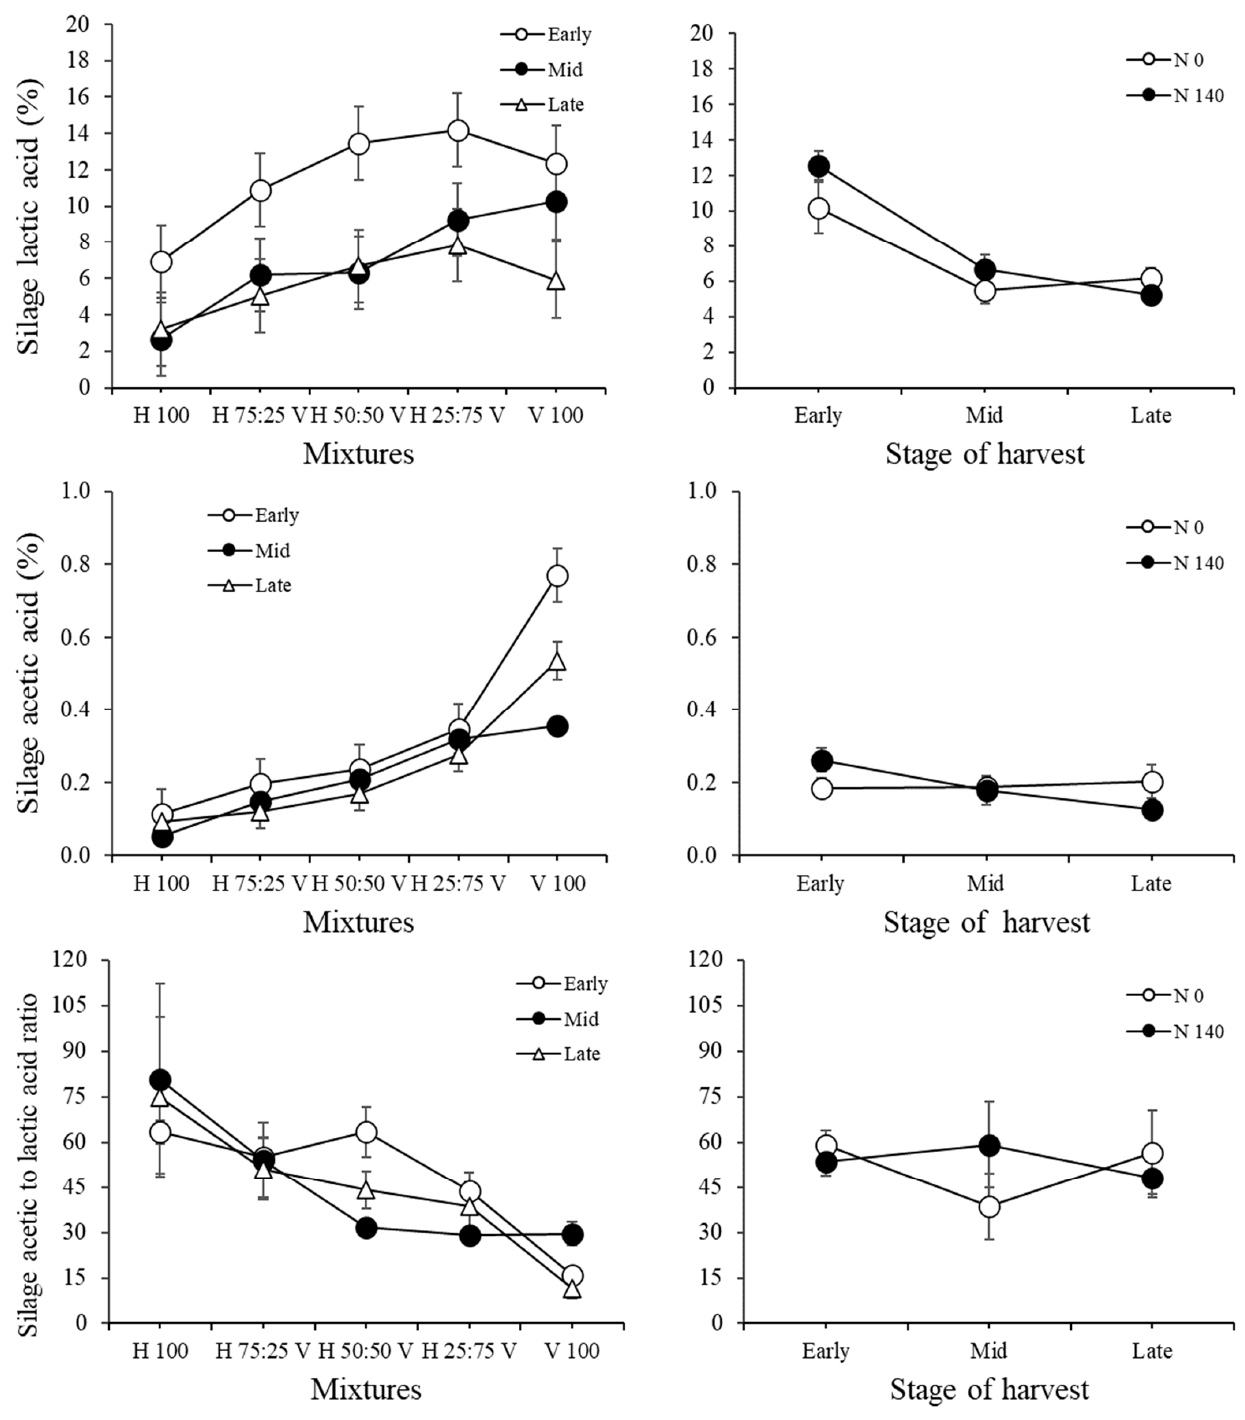
Figure 15. Silage lactic acid concentration ( above ), acetic acid concentration ( middle ) and acetic to lactic acid ratio ( below ) as affected by SH × MX interaction ( left ) and SH × NF interaction ( right ). On the left, values are LSmeans across all treatments along with standard error estimate of the LSmeans since the design was unbalanced between the faba bean crop ( n = 9) compared to the mixtures and the barley crops ( n = 18). On the right, only data of the barley-containing treatments were used. Each point represents the arithmetic mean ( n = 24) and its computed standard error. By contrast, the isovaleric acid showed an inverse trend both for MX and